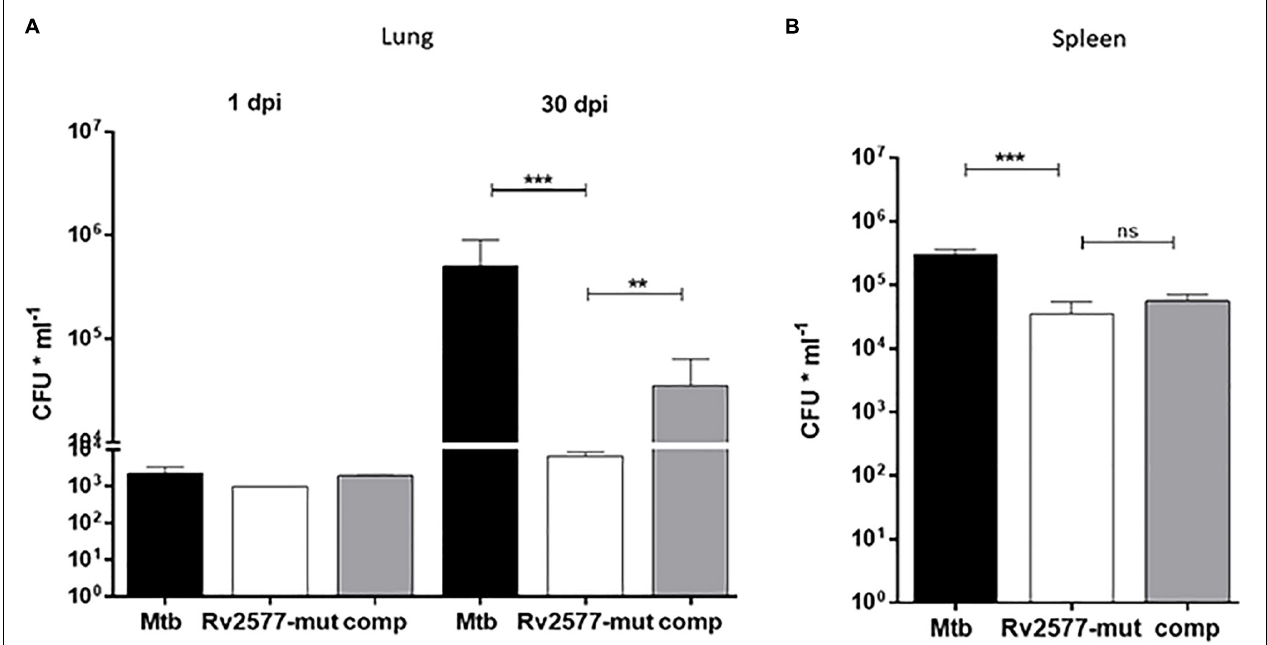
FIGURE 4 | The Rv2577 mutation attenuates M. tuberculosis virulence in mice. The bacterial loads of M. tuberculosis wild type (Mtb), Rv2577 mutant (Rv2577-mut) and the complemented (Rv2577-comp) strains were measured as colony forming units (CFU*ml - 1 ) in the lungs (A) or spleen (B) of BALB/c mice at 1 and 30 days post-infection (dpi). All strains showed similar pulmonary bacillary load at 1dpi. The values are expressed as the mean ± SD. of CFUs for mouse organs ( n = 6). *** p < 0.0001, ** p < 0.001 calculated using ANOVA